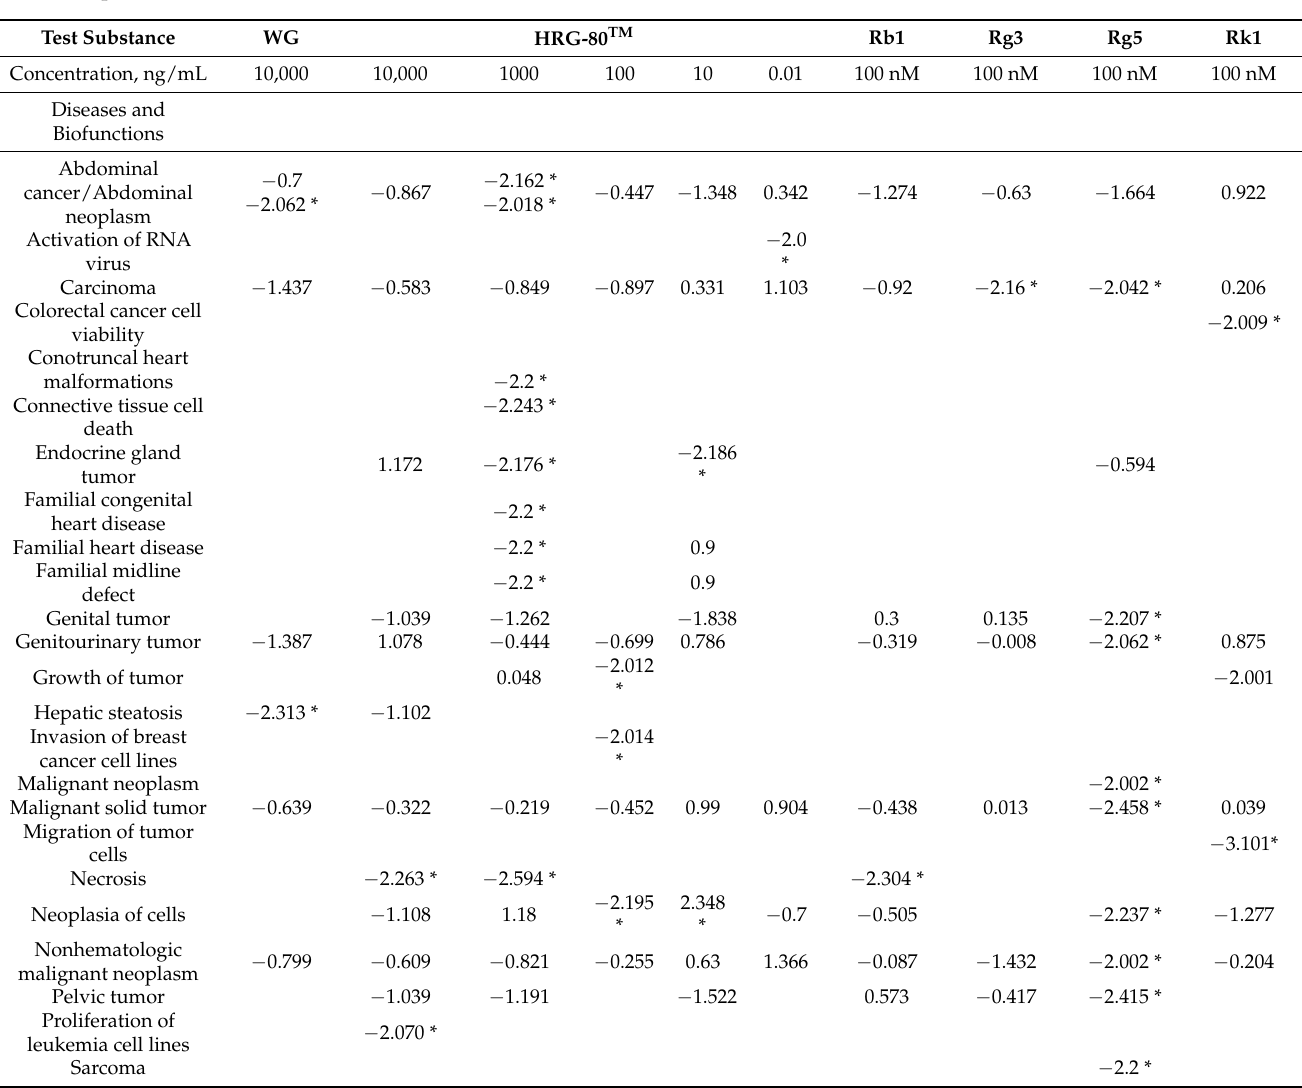
Table 3. Predicted effects of ginseng extracts HRG80 TM and WG, and ginsenosides Rb1, Rg3, Rg5 in various diseases and biofunctions expressed by activation z-score values. Positive values show predicted activation; negative values showpredicted